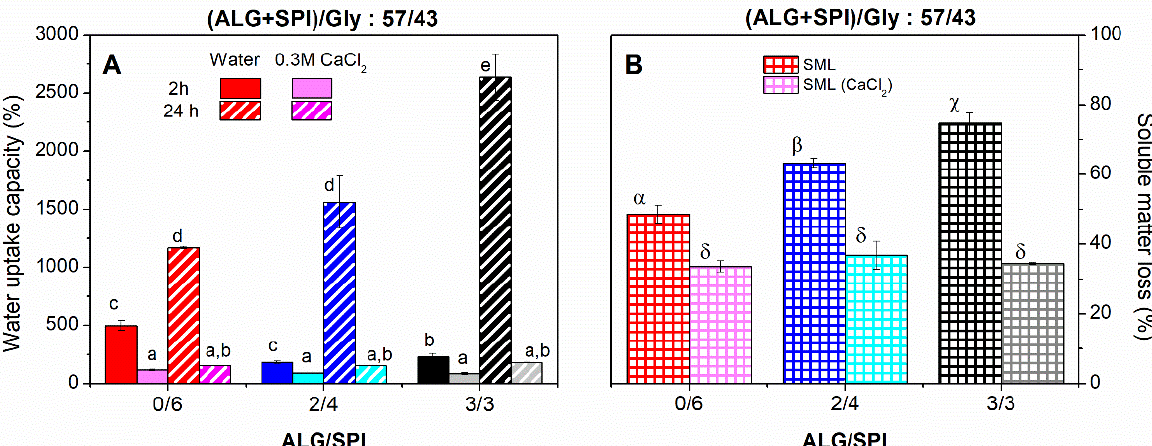
Figure 7. Water uptake capacity after 2 and 24 h of water or CaCl 2 solution (0.3 M) immersion ( A ) and soluble matter loss ( B ) of alginate + soy protein isolate/glycerol composites with ALG/SPI ratios: 0/6, 2/4, and 3/3, maintaining the ALG + SPI/Gly ratio: 57/43. Lower-case, upper-case, and Greek letters indicate that average values are statistically different ( p < 0.05).